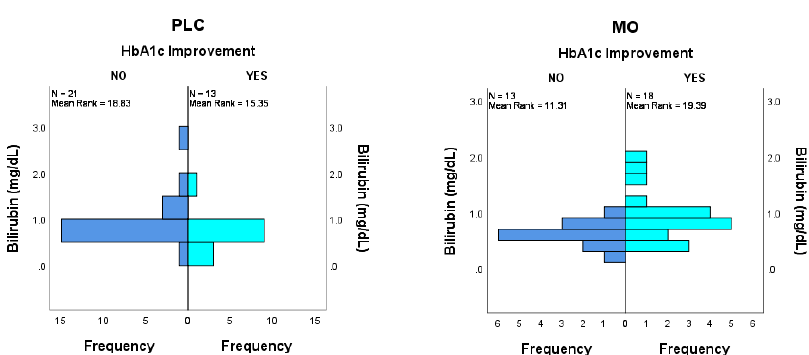
Figure 2. Potential predictor variables between subjects improving and not improving HbA1c during the intervention in the MO group. Bacteroides , ANCOVA with BMI adjustment, p = 0.085; GOT, GPT and Bilirubin, Mann Whitney U test, p = 0.032 p = 0.022 and p = 0.014, respectively. No differences were found in basal values in the PLC group in those